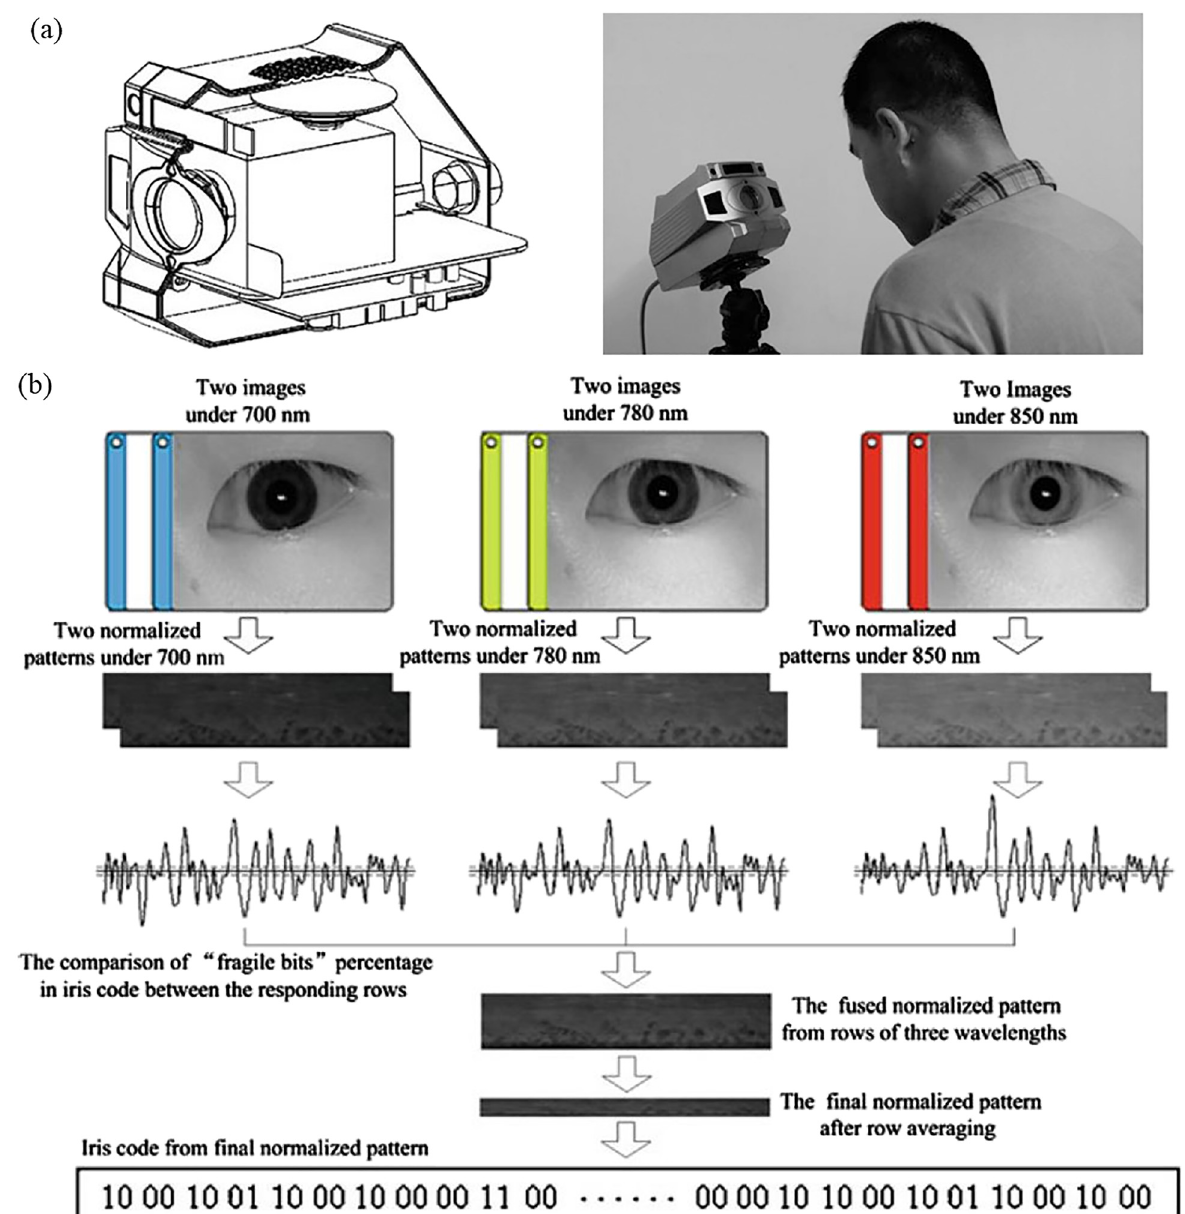
Figure 5: Multispectral iris recognition system and data fusion process. (a) Schematic drawing of multispectral iris capture device (left) and an optical image showing data collection process (right). (b) Fusing process of multispectral iris images at 700, 780 and 850 nm, including all the pigment information within iris. (a) – (b) are adapted with permission from Springer Nature: Multispectral Biometrics, by Zhang et al. [39]. Copyright